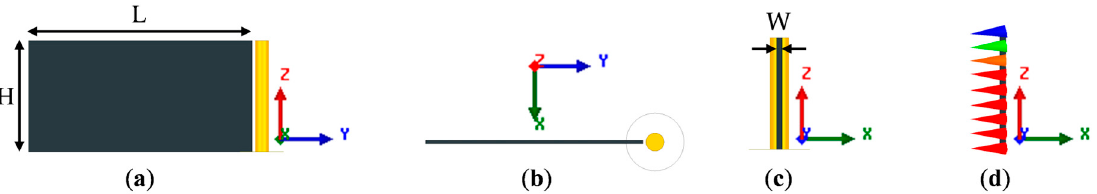
Figure 1. Geometry of the low-loss host substrate of width ( W ), length ( L ), and height ( H ): ( a ) Front view